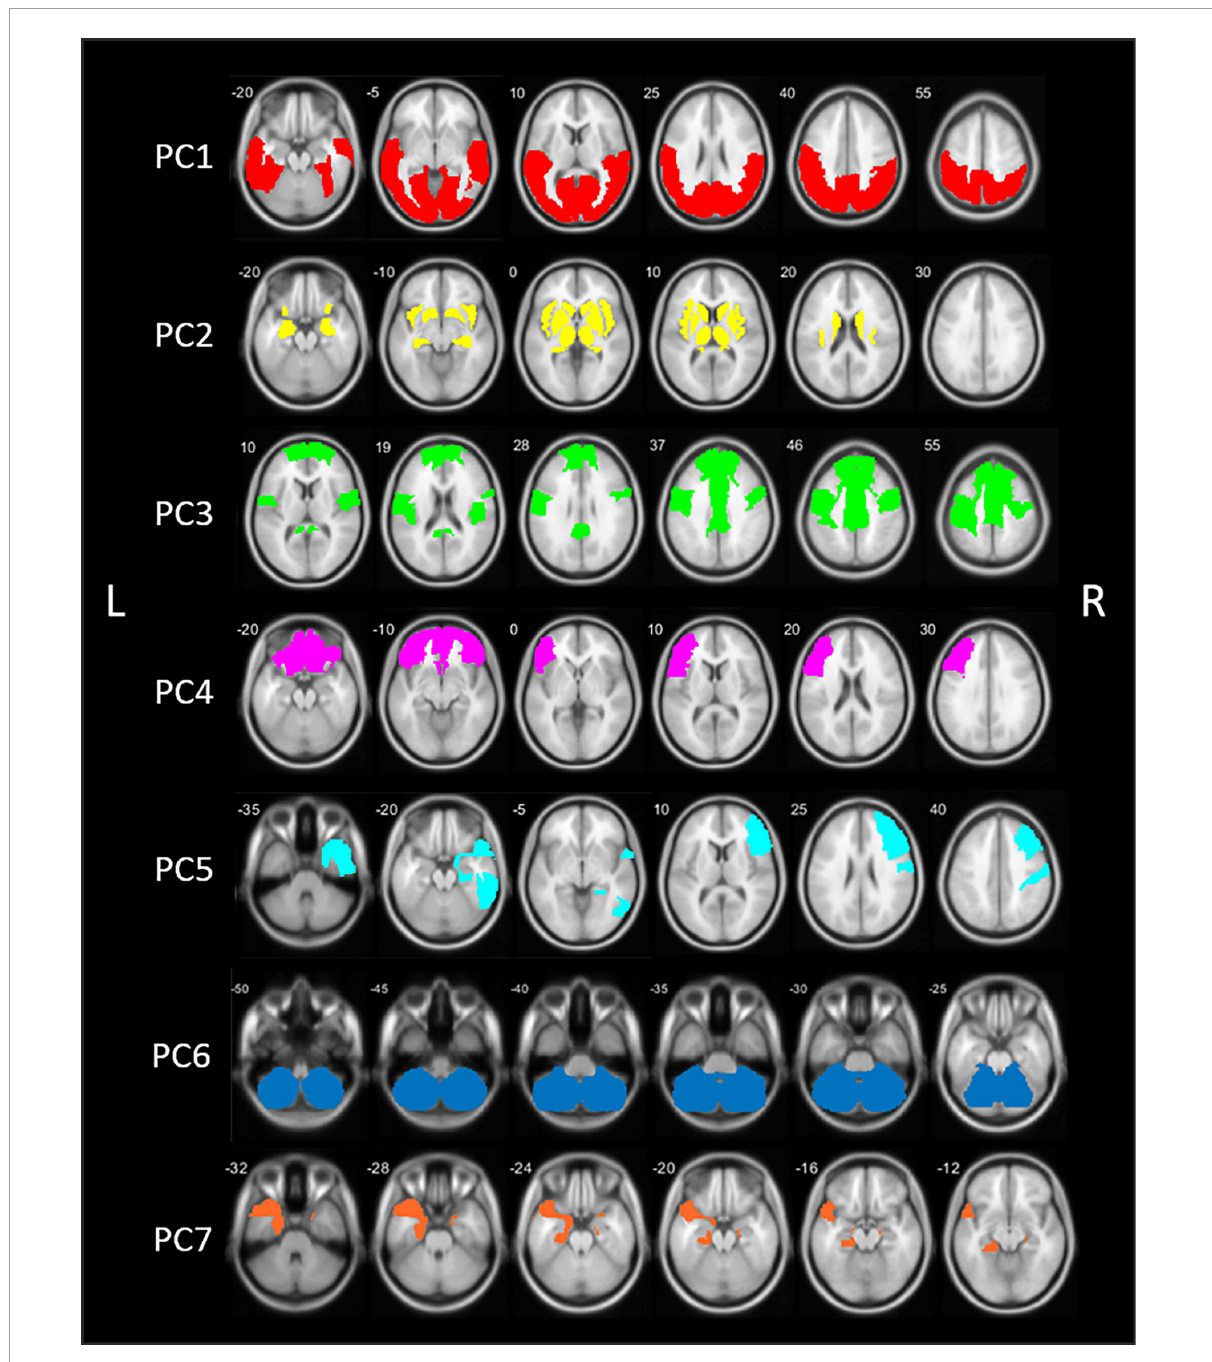
FIGURE1 Schematic representation of the seven principal components (PCs) of the principal component analysis (PCA) in patients with Parkinson’s disease (PD). PC, Principal component; L, left; R, right.